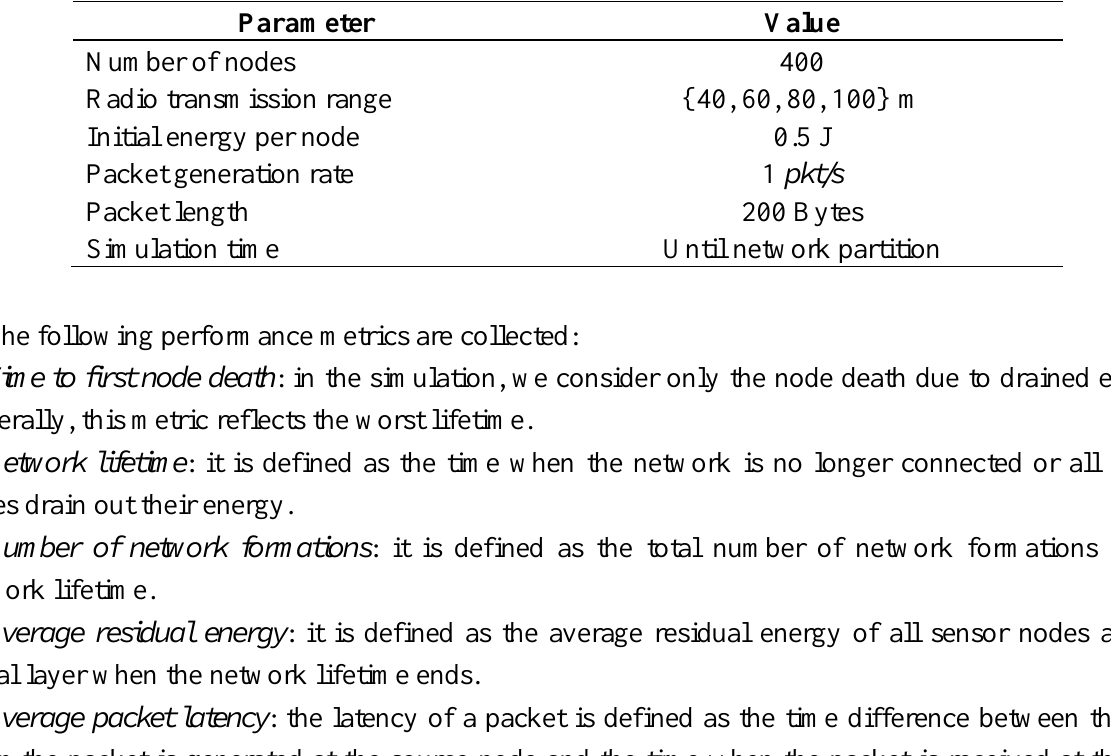
Table 1. Simulation